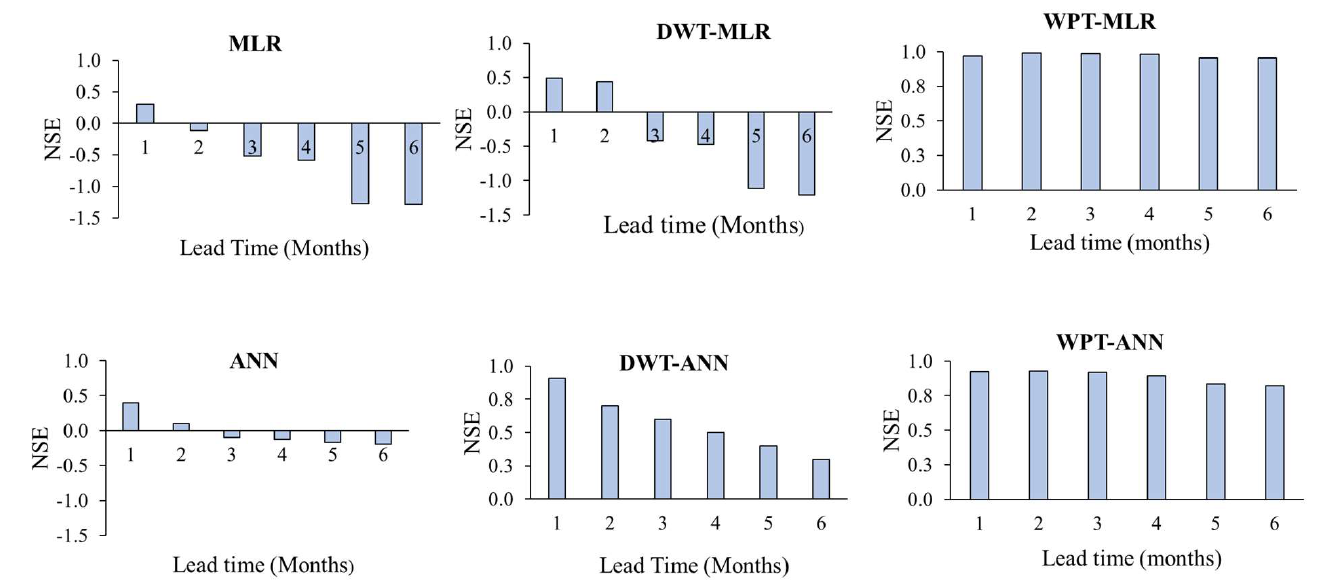
Figure 6. Different model’s performance pertaining to SPI-3 forecast under different lead times.